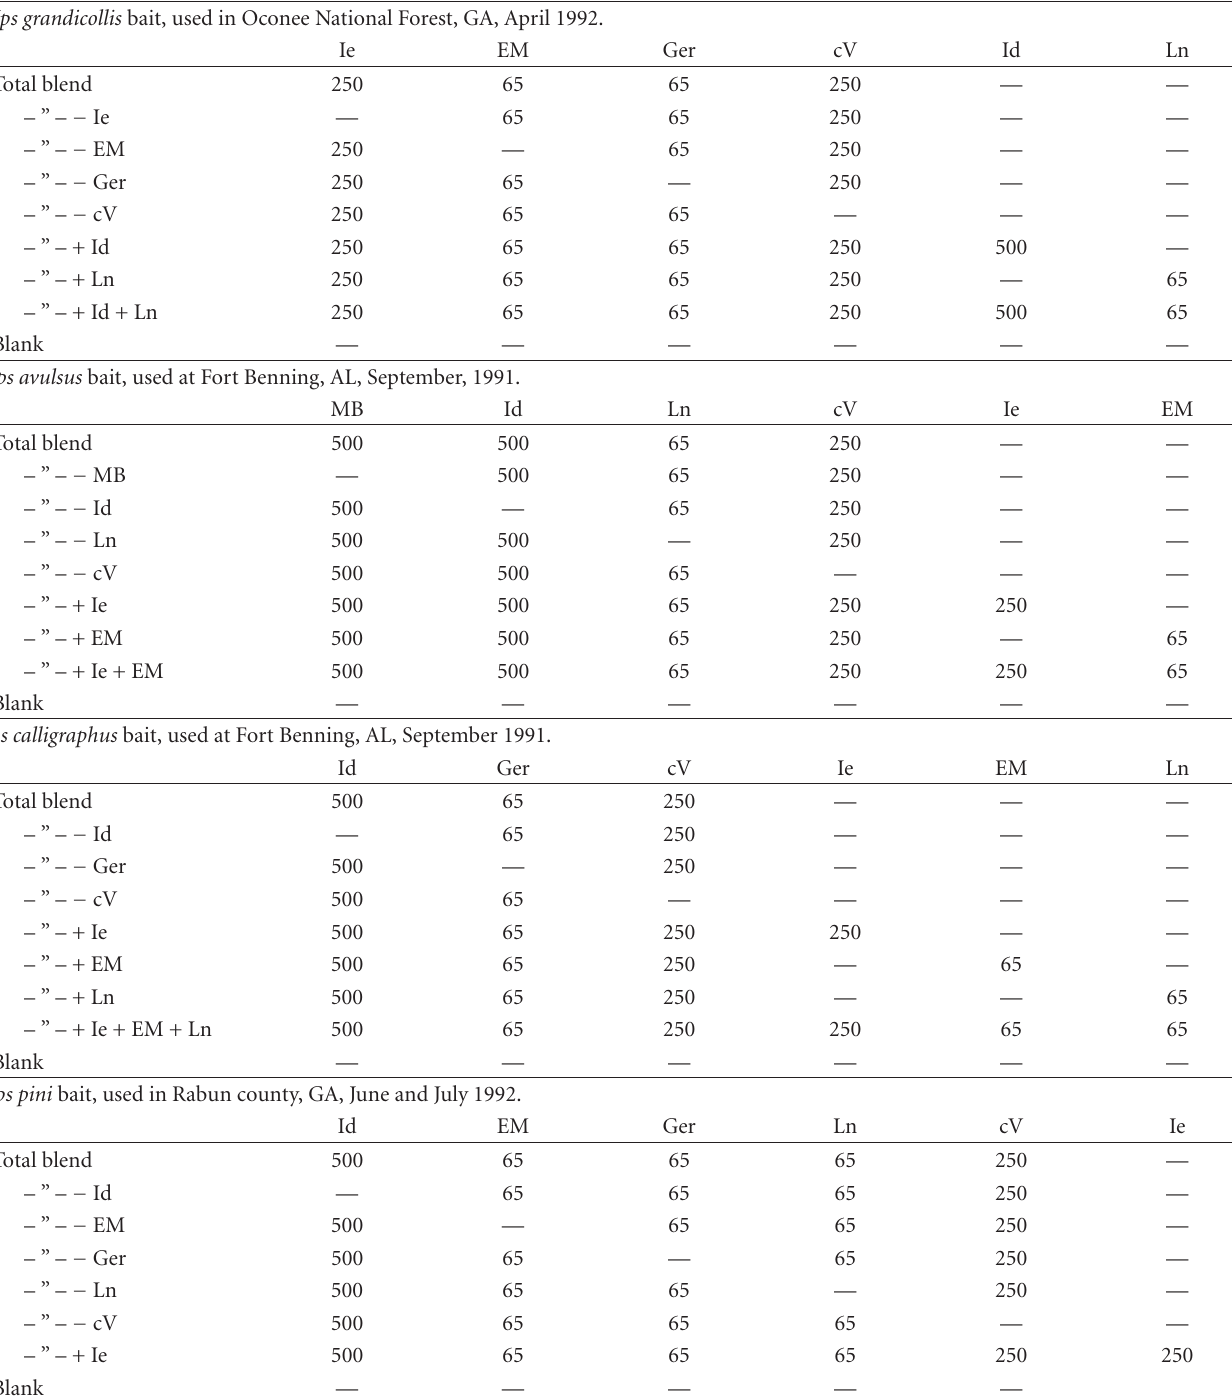
Table 3: Subtractive bioassay: pheromone candidates released from Wick-baits:—for abbreviations, see Table 1. Release rates are given in μ